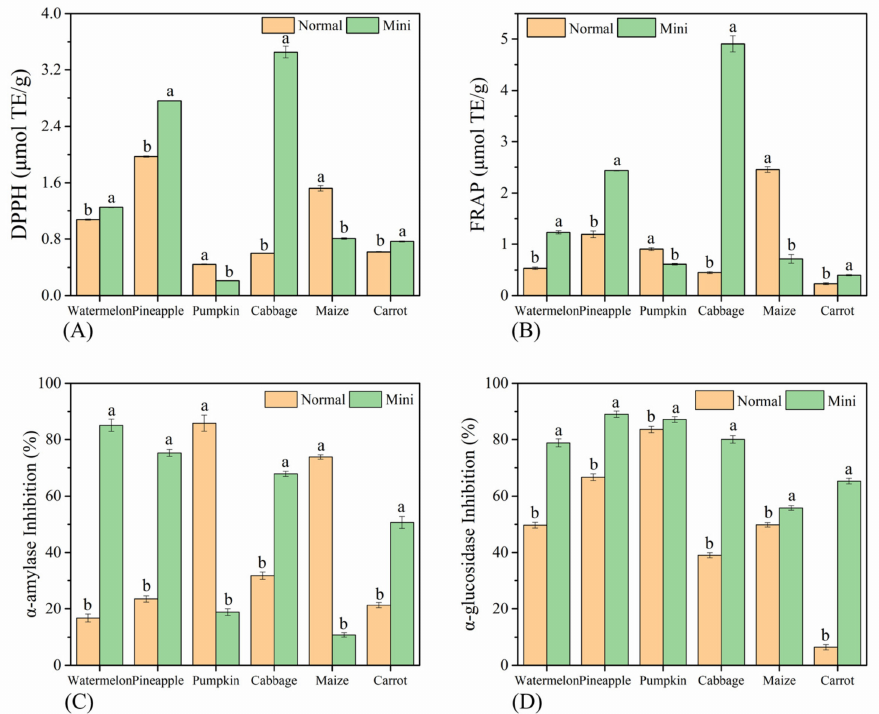
Figure 4. Biological activities of MFV and NFV: ( A ) DPPH radical scavenging activity; ( B ) FRAP assays; ( C ) α -amylase inhibition; ( D ) α -glucosidase inhibition. Values with different letters are significantly different ( p < 0.05) from each